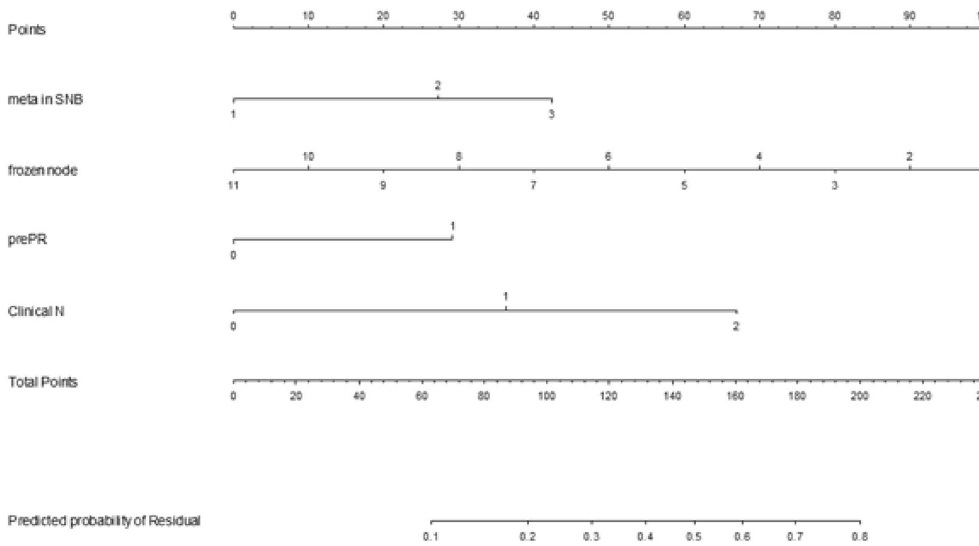
Figure 1. The nomogram to predict non-sentinel lymph node metastasis in breast cancer patients with 1–3 positive sentinel lymph node(s) on a frozen biopsy result.